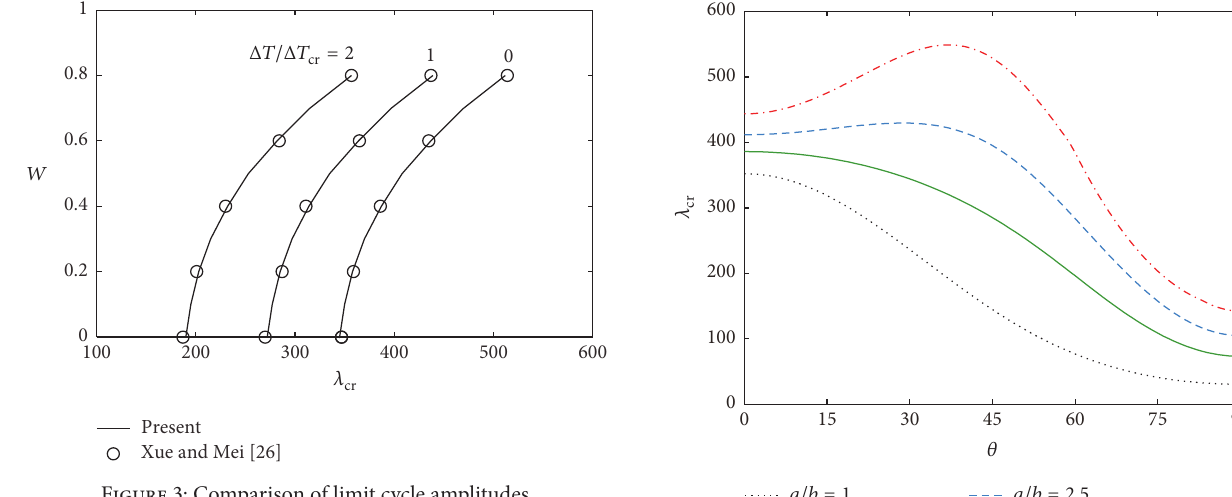
Figure 3: Comparison of limit cycle amplitudes.